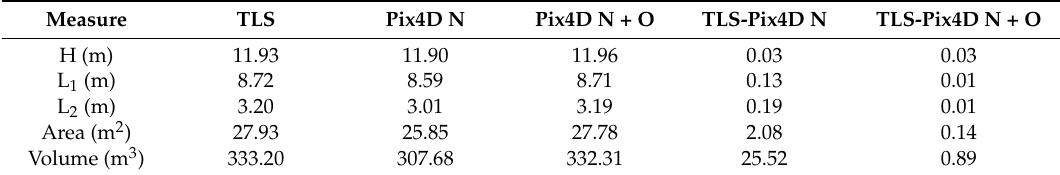
Table 11. Comparison between the measurements on the Pix4D and TLS point